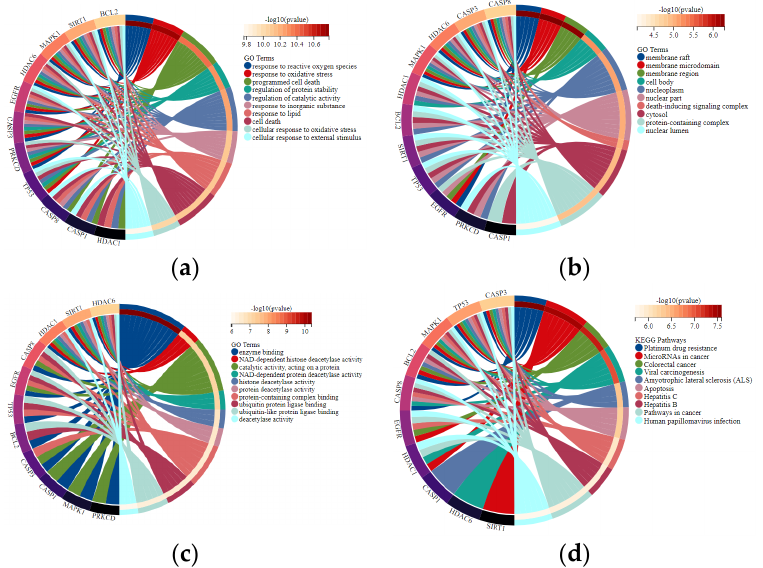
Figure 4. GO enrichment and KEGG pathway analysis represented in a chord plot: ( a ) biological processes; ( b ) cellular components; ( c ) molecular functions; ( d ) signaling pathways.